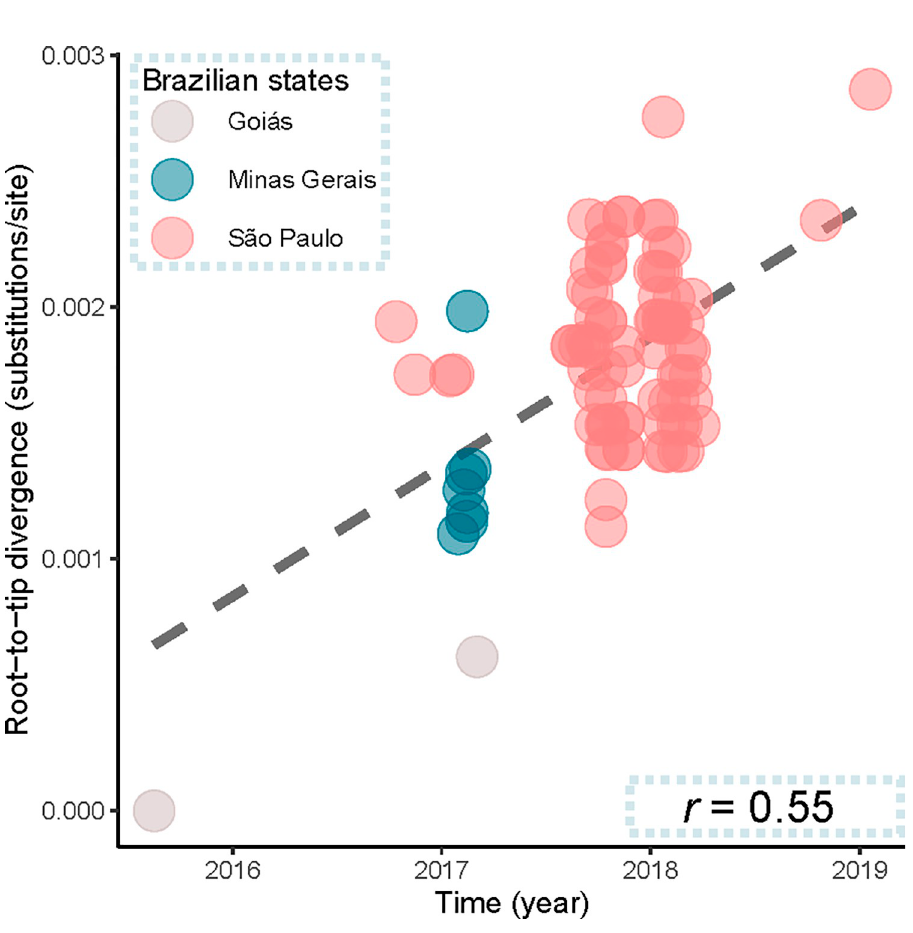
Fig 4. Correlation between genetic divergence and sampling time was obtained by a root-to-tips analysis using the YFV sequences. Root-to-tips distances were inferred using a maximum likelihood phylogeny for the genotype South American I, Clade II, (dataset-2).